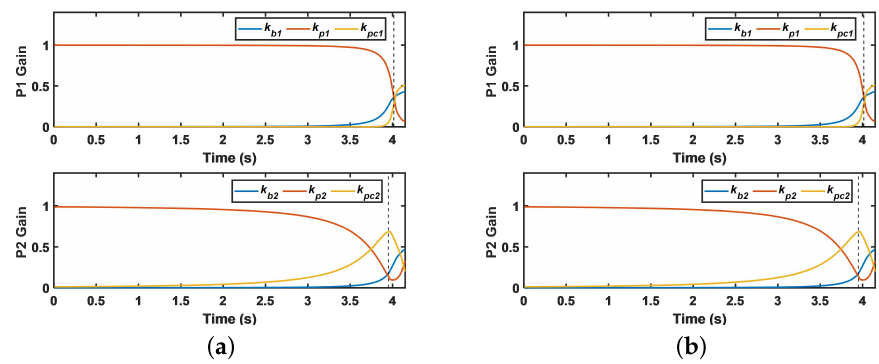
Figure 10. Gain of pursuer: ( a ) gain of p 1 and p 2 and ( b ) gain of p 3 and p 4 .